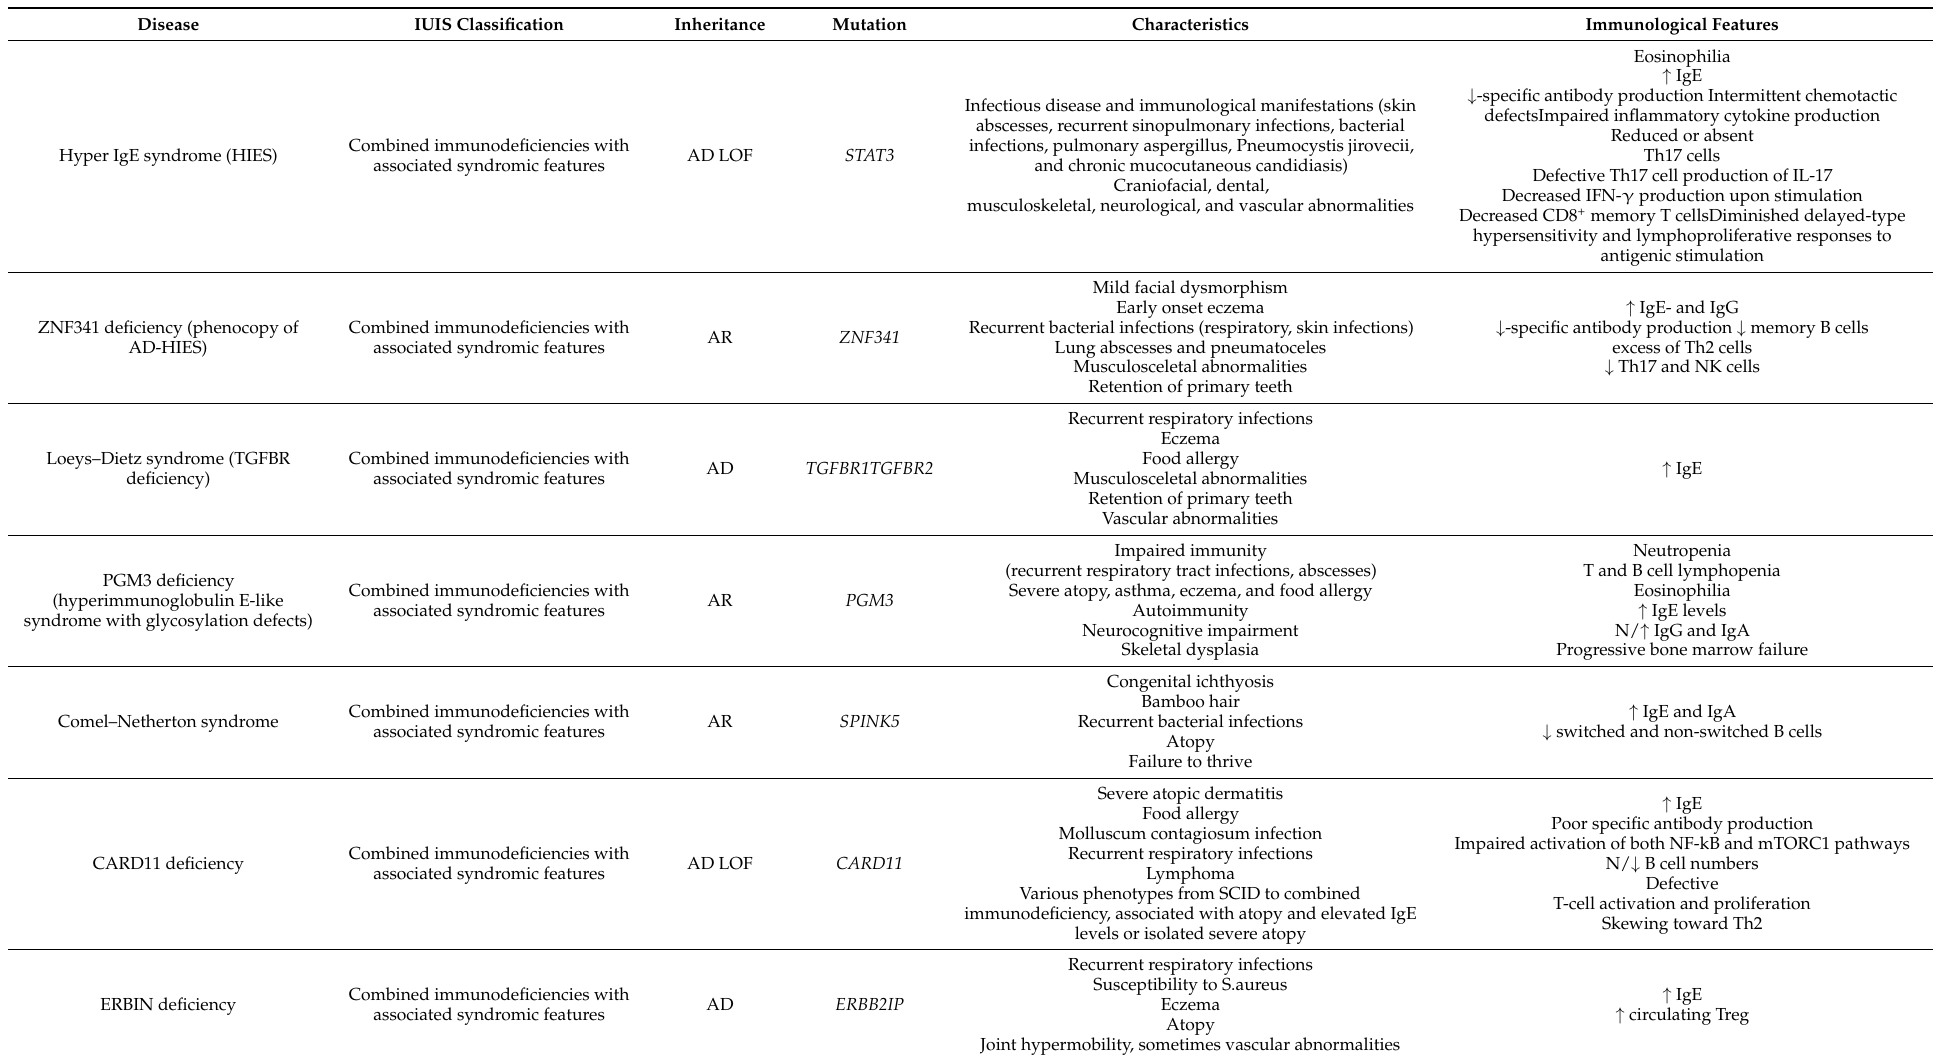
Table 1. Inborn errors of immunity with elevated